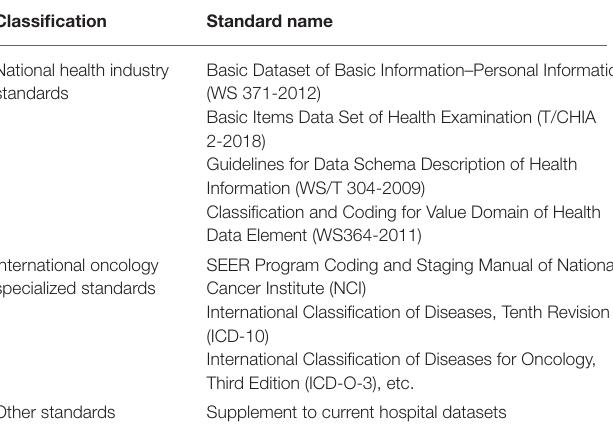
TABLE 2 | Some referenced dataset